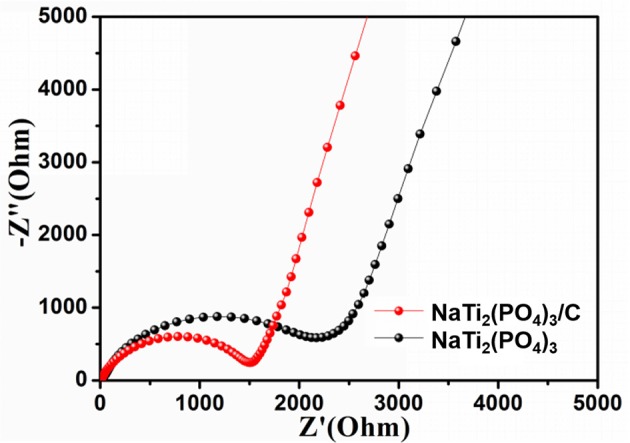
Nyquist plots of NaTi2(PO4)3/C and NaTi2(PO4)3.